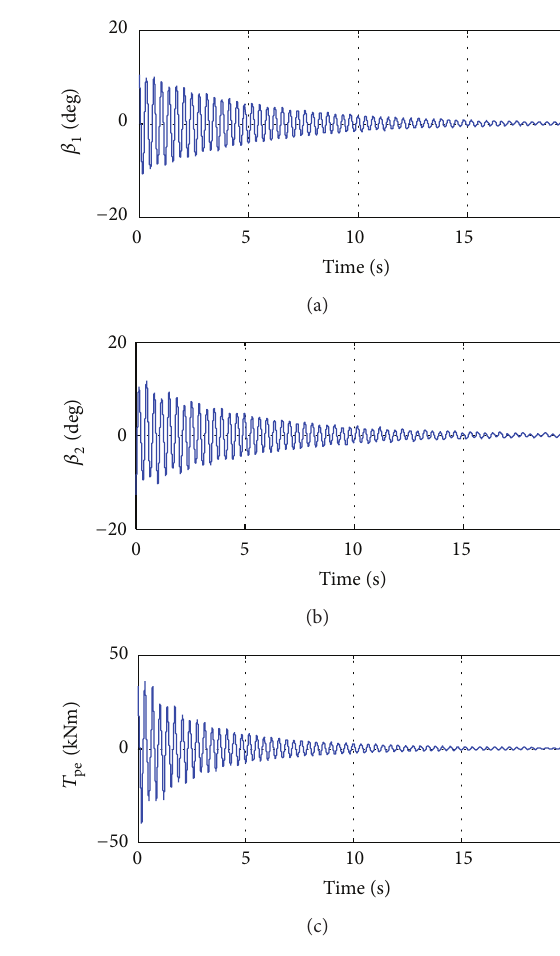
Figure 6: Control surface deflection angles and actuator torques for exact feedback